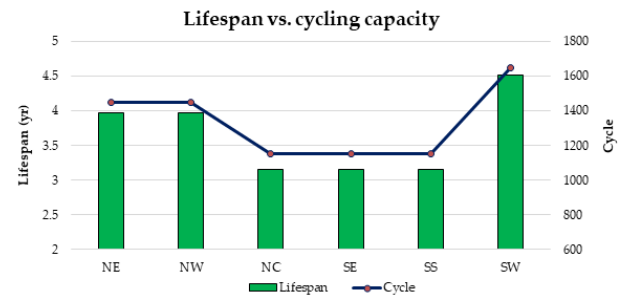
Figure 21. Battery cycling capacity and the